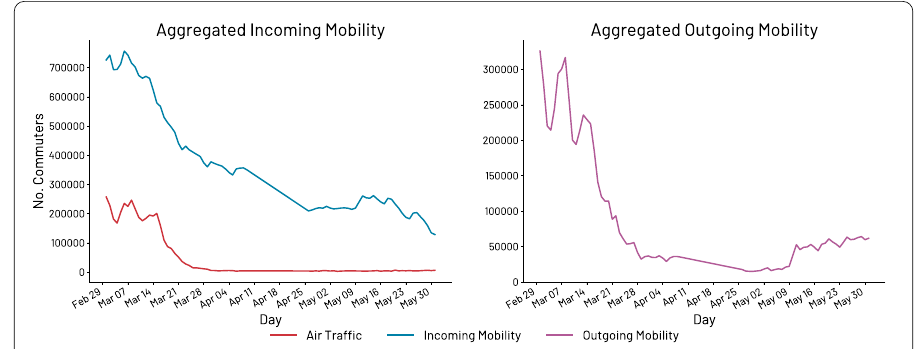
Figure 2 On the left, commuters traveling to UK measured with roaming data (blue) and air passengers from air traffic data (red). On the right, commuters from UK to other countries. In both cases, we can spot the effects of the COVID-19 pandemic (e.g., suggestions against all but essential travels, travel bans, lockdown and other countermeasures that impacted international